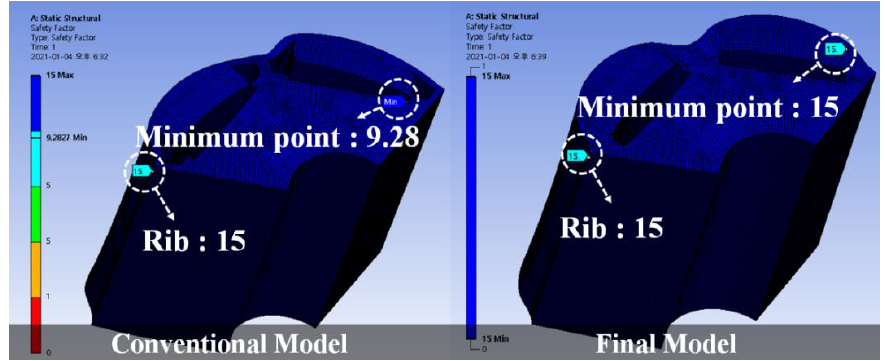
Figure 20. Comparison of the safety factor (4000